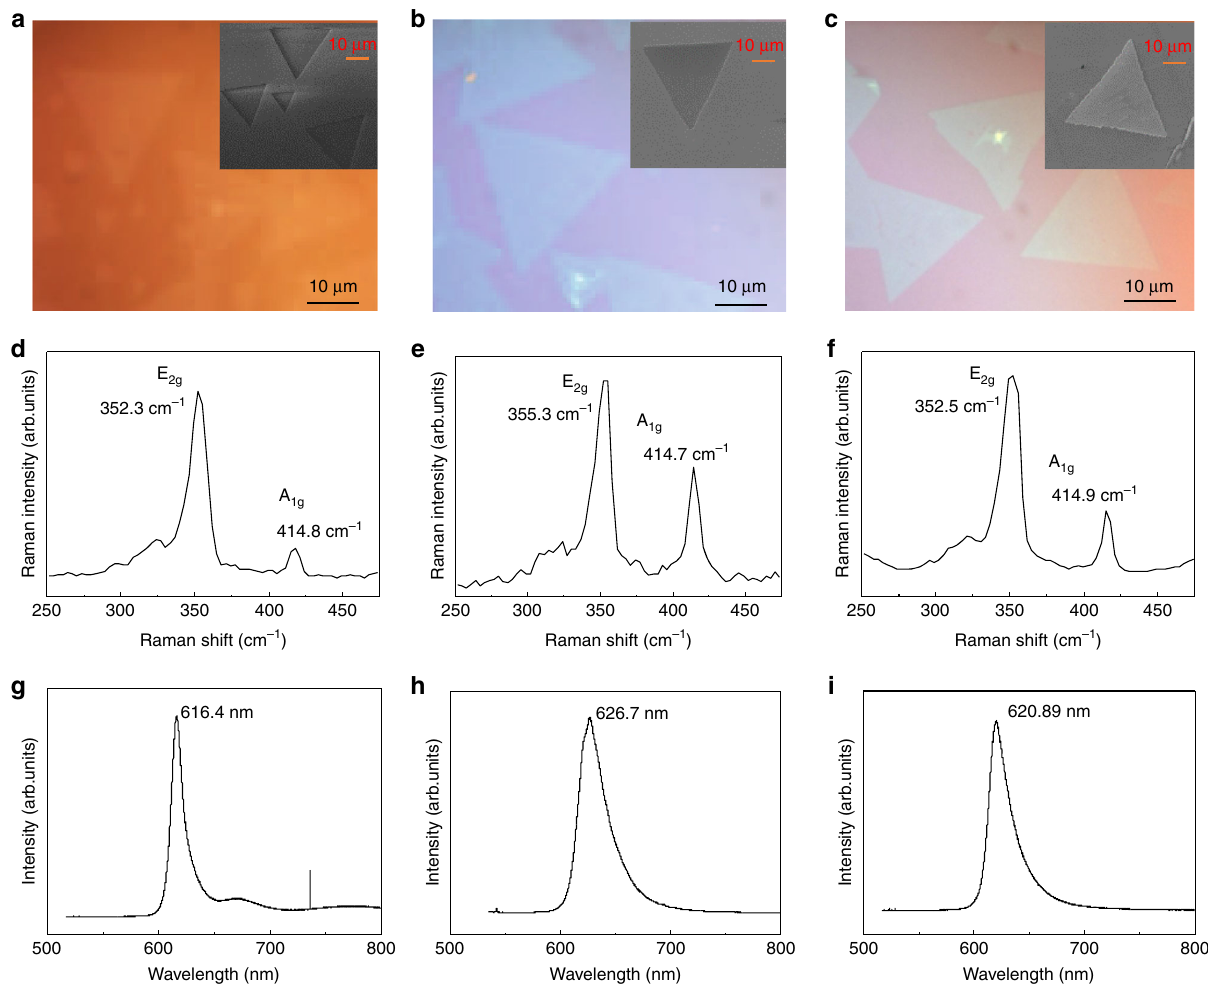
Fig. 1 WS 2 monolayer characterization. Optical microscope images and SEM images (insets) of monolayer WS 2 on sapphire substrate ( a ), SiO 2 substrate ( b ), and EuS substrate ( c ). Room temperature Raman and PL spectra of WS 2 on sapphire ( d , g ), SiO 2 ( e , h ), and EuS ( f , i Figure 2a, c shows the re fl ectance spectra of monolayer WS 2 on Si/SiO 2 substrate, measured at 7 K and a magnetic fi eld of 0 and 7 WS 2 on ferromagnetic EuS substrate measured at identical between the re fl ectance of WS 2 and either Si/SiO 2 or EuS substrate background. A complex (absorptive + dispersive) Fano transition energies (Supplementary Fig. 2 and Supplementary